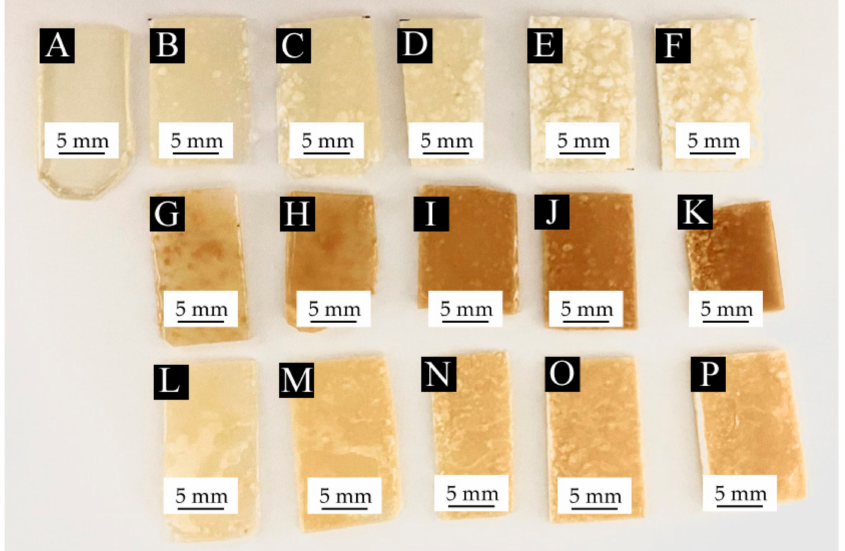
Figure 5. Waterborne films containing different content of microcapsules: ( A ) no microcap- sules, ( B ) 3.0 wt.% transparent shellac microcapsules, ( C ) 6.0 wt.% transparent shellac microcap- sules, ( D ) 9.0 wt.% transparent shellac microcapsules, ( E ) 12.0 wt.% transparent shellac microcap- sules, ( F ) 15.0 wt.% transparent shellac microcapsules, ( G ) 3.0 wt.% purple shellac microcapsules, ( H ) 6.0 wt.% purple shellac microcapsules, ( I ) 9.0 wt.% purple shellac microcapsules, ( J ) 12.0 wt.% purple shellac microcapsules, ( K ) 15.0 wt.% purple shellac microcapsules, ( L ) 3.0 wt.% yellow shellac microcapsules, ( M ) 6.0 wt.% yellow shellac microcapsules, ( N ) 9.0 wt.% yellow shellac microcapsules, ( O ) 12.0 wt.% yellow shellac microcapsules, ( P ) 15.0 wt.% yellow shellac